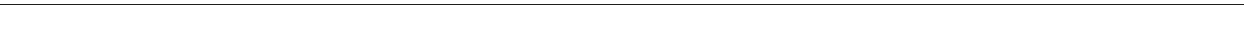
Fig. 6 Perivascular FAP + HO-1 + macrophages can facilitate transendothelial migration of tumour cells through their HO activity. a Representative images of frozen sections of a 4T1 tumour stained with DAPI (nuclei; blue) and antibodies against F4/80 (green) and HO-1 (red); functional vasculature was labelled in vivo using dextran-FITC (yellow). b Quanti fi cation of F4/80 + TAMs co-expressing HO-1 in avascular and perivascular regions ( n = 12 sections across four tumours in each group). c Tumour growth curves of mice bearing established 4T1 tumours treated with vehicle (blue) or 25 μ mol/kg/day SnMP (orange) ( n = 6), arrow marks the initiation of treatment. d Metastatic nodules on the lung surface of mice bearing 4T1 tumours treated with vehicle ( n = 16) or 25 μ mol/kg/day SnMP ( n = 15) at day 24 post inoculation of tumour cells (data from three independent experiments presented). e – i 4T1 tumours or lungs in mice treated with vehicle (blue) or SnMP (orange) as described in c were analysed. e Abundance of TAMs, monocytes and neutrophils in enzyme-dispersed tumours ( n = 5 per condition). f Representative fl ow cytometry gating strategy for MAMs. g Representative surface FAP staining (blue) and isotype control staining (grey shaded) of MAMs in the lungs of 4T1 tumour-bearing mice (day 24). h , i Abundance of lung neutrophils ( h ) and MAMs ( i ) ( n = 4 per condition). j Representative fl ow cytometry gating strategy (left) and abundance (right) of 4T1-eGFP cells in enzyme-digested lungs 48 h after i.v. injection of 4T1-eGFP in mice treated with vehicle (blue) or 25 μ mol/kg/day SnMP (orange) ( n = 10 mice). k – m Abundance of metastatic nodules on the surface of lungs in mice bearing 4T1 tumours grown in WT ( n = 17) and Il6 − / − ( n = 9) mice ( k ), WT ( n = 12) and Il4r − / − ( n = 8) mice ( l